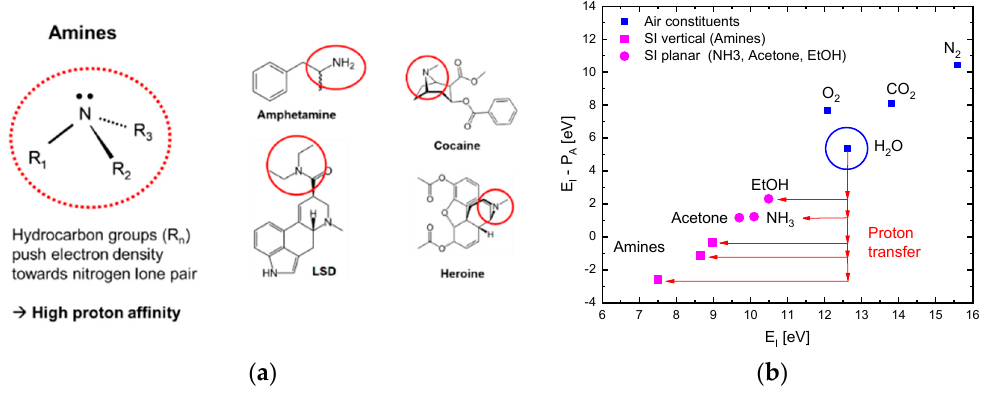
Figure 3. ( a ) Molecular structure of amines, leading to extremely high values of proton affinity (PA) and low effective ionization energies, E I − PA ; ( b ) residual ionization energy, E I − PA , after proton attachment as a function of the free-space ionization energy, E I , of different groups of analyte gases; Data redrawn from [19].